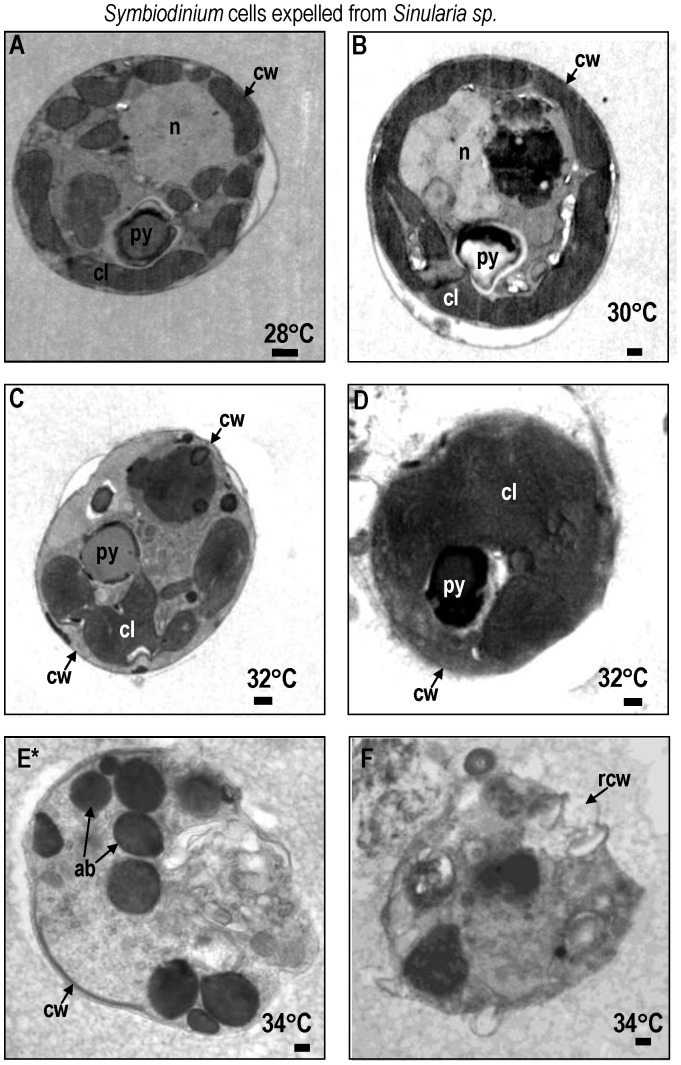
TEM of Symbiodinium cells lost from Sinularia lochmodes at temperatures 28° to 34°C. Most Symbiodinium cells appeared normal at 28 to 30°C (A,B).Symptoms of reversible early- to mid-stage apoptosis (C) or necrosis (D) occurred at 32°C within 12 h. After 9 h at 34°C, many Symbiodinium cells exhibited symptoms of late non-reversible apoptosis (E) and necrosis (F) symptoms. Symbols: ab = apoptotic body, chr = chromosome, cl = chloroplast, cw = cell wall, gx = glyoxysome, m = mitochondria, n = nucleus, py = pyrenoid, rcw = ruptured cell wall, sg = starch grain. Scale bar = 500 nm.